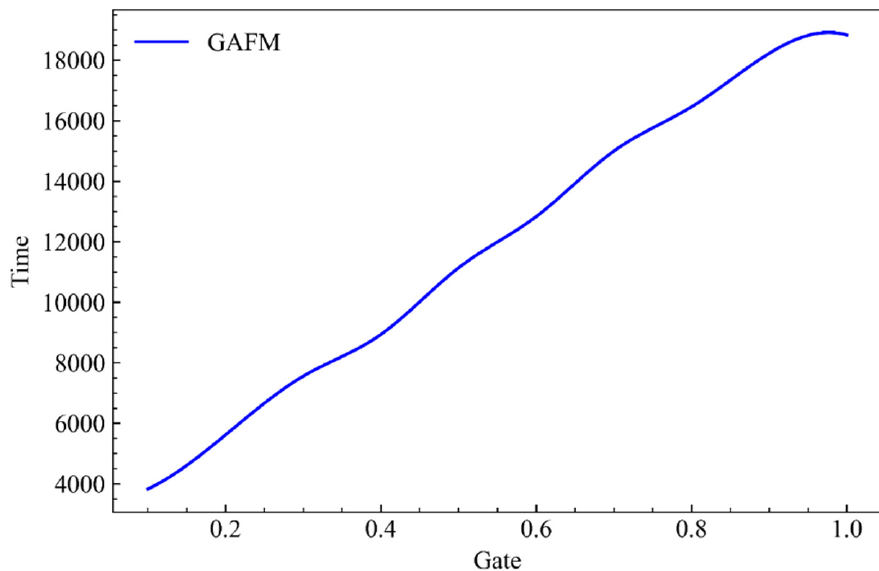
Figure 15. Running time of GAFM under the influence of g.